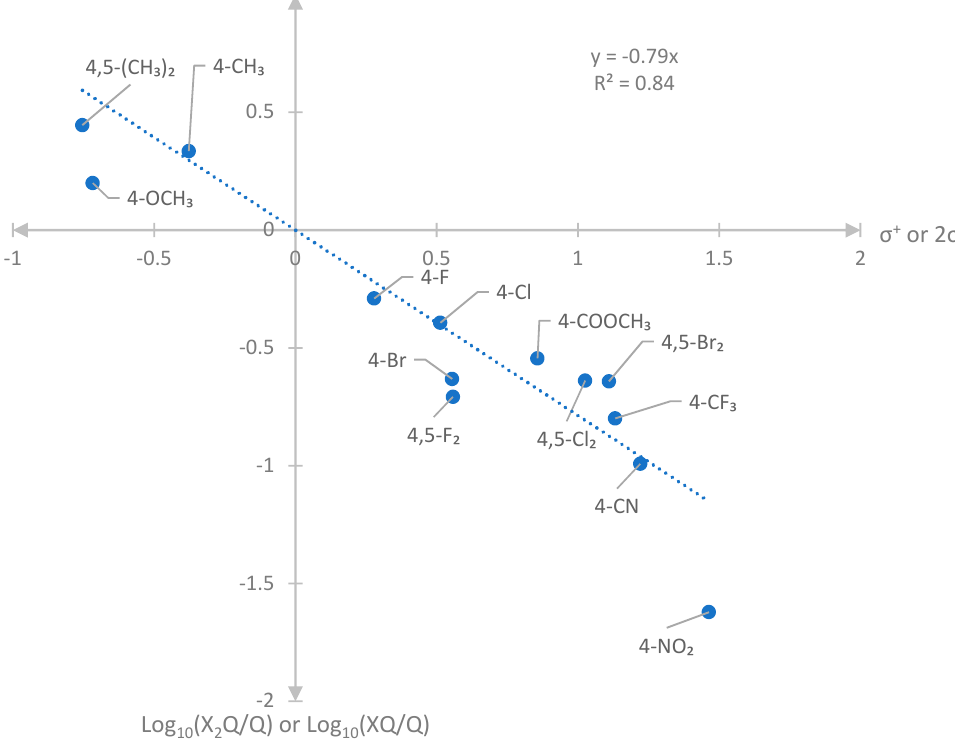
Figure 4. Hammett plot of XQ/Q ratio with standard composite σ + constants and X 2 Q/Q ratio with doubled standard composite σ + constants.